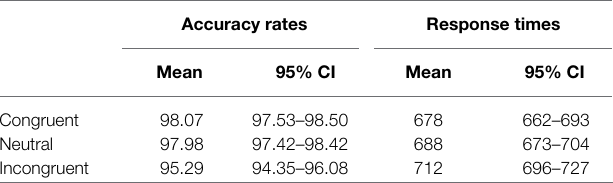
TABLE 5 | Mean accuracy rates (%), mean correct response times (ms) and the 95% confidence intervals (CI) from the lower level to the upper level for the Simon task by trial